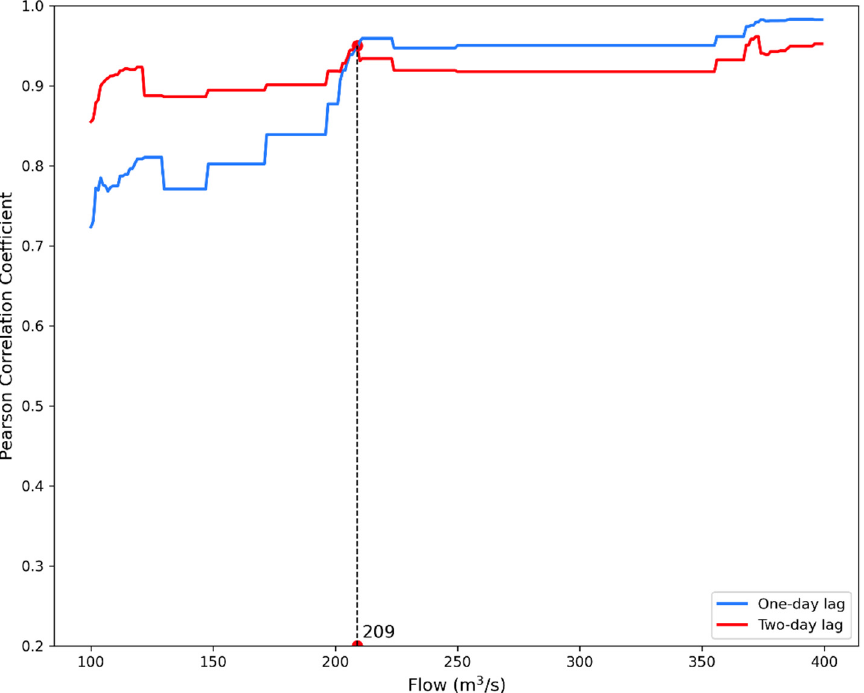
Figure 2. The Pearson correlation between downstream (Torgau) flow data and one-day or two-days-ahead upstream (Schoena) flow data.